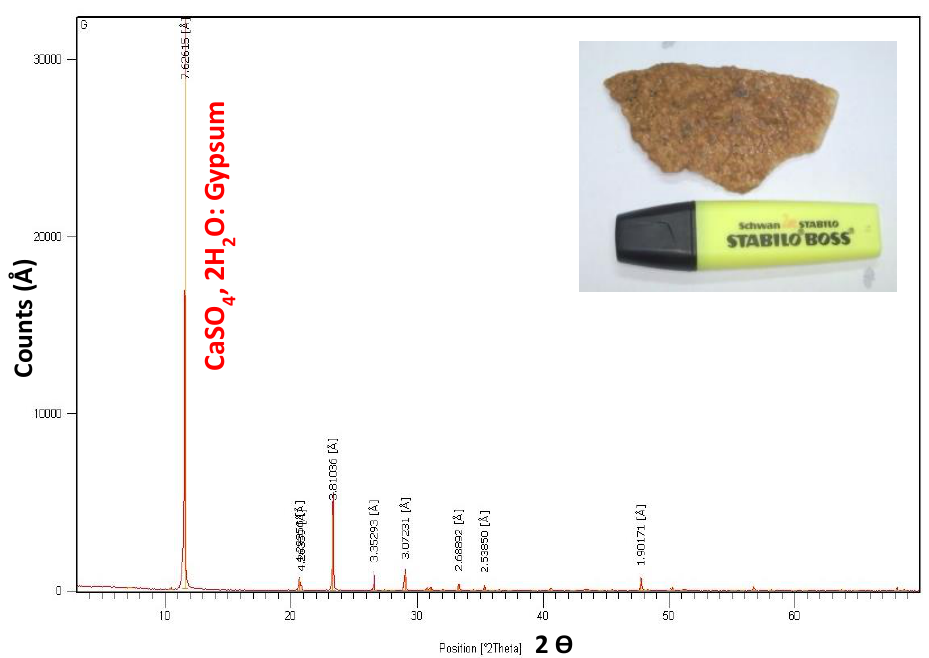
Figure 10. XRD Spectrum of gypsum found in the geologic formations.